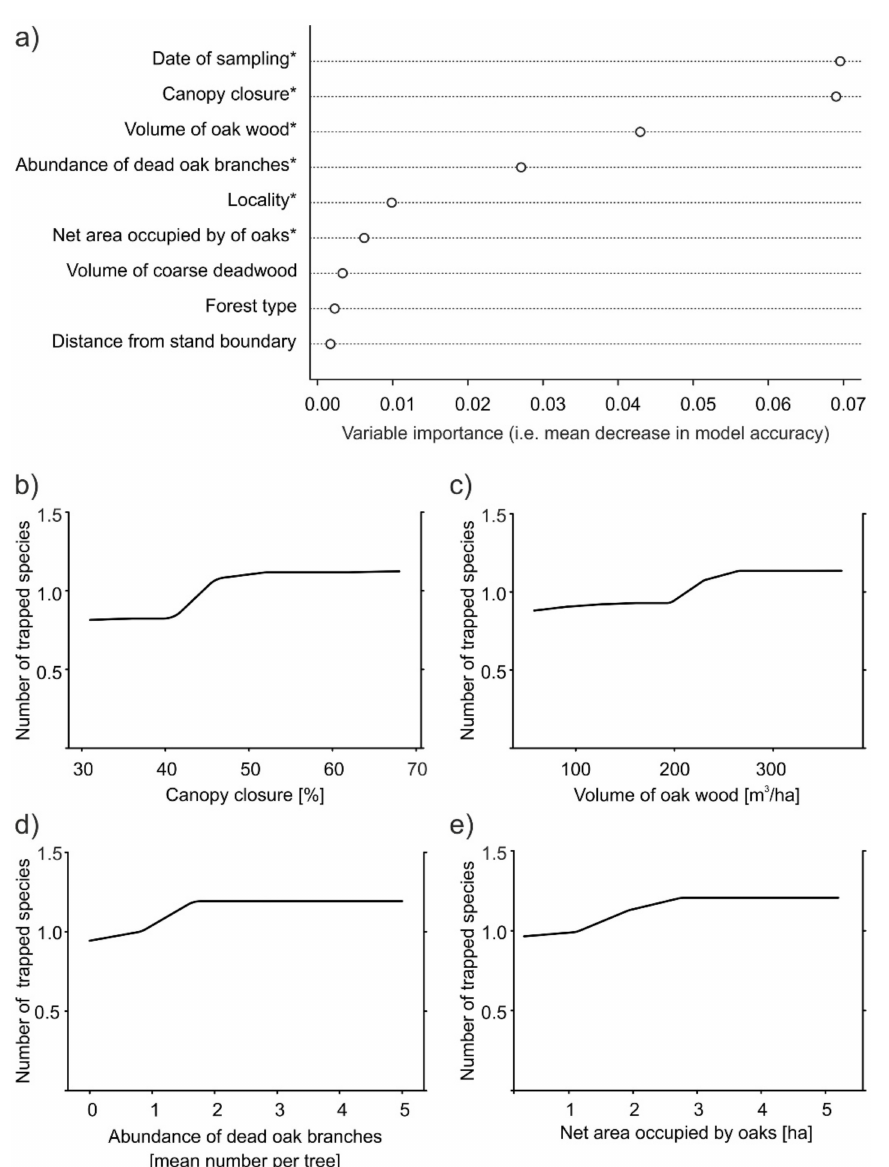
Figure 5. Results of random forest regression of the mean number of ambrosia beetle species captured per trap per 2-week period from April to August as the response variable: ( a ) plot of variable importance (based on the decrease of mean model accuracy with omission of the variable). Variables with a significant effect ( p < 0.05) are denoted with asterisk (*); ( b – e ) partial dependence plots showing the marginal effect of the indicated explanatory variables on the mean number of ambrosia beetle individuals trapped during the eight 2-week periods from April to